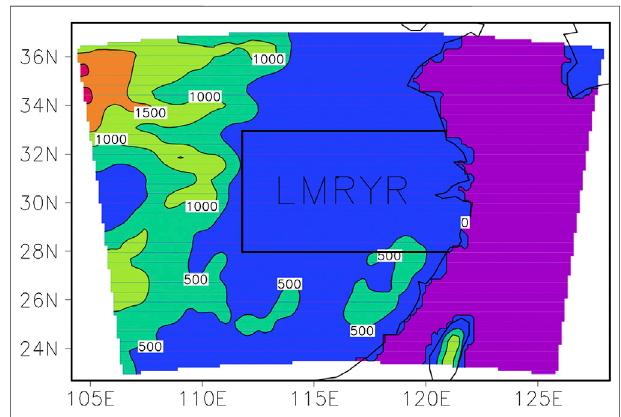
FIGURE 1 | Model domain, topography (shaded, unit: m), and the area of the middle and lower reaches of the Yangtze River.